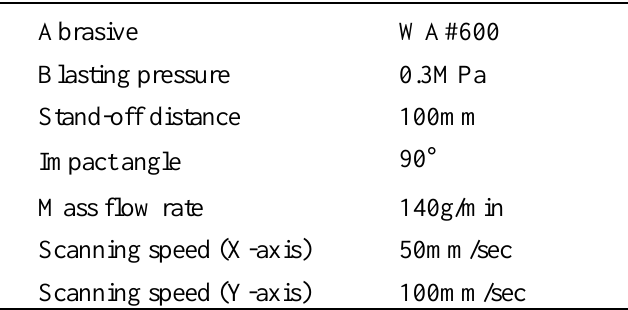
Table 3. Blasting conditions for the experiments.